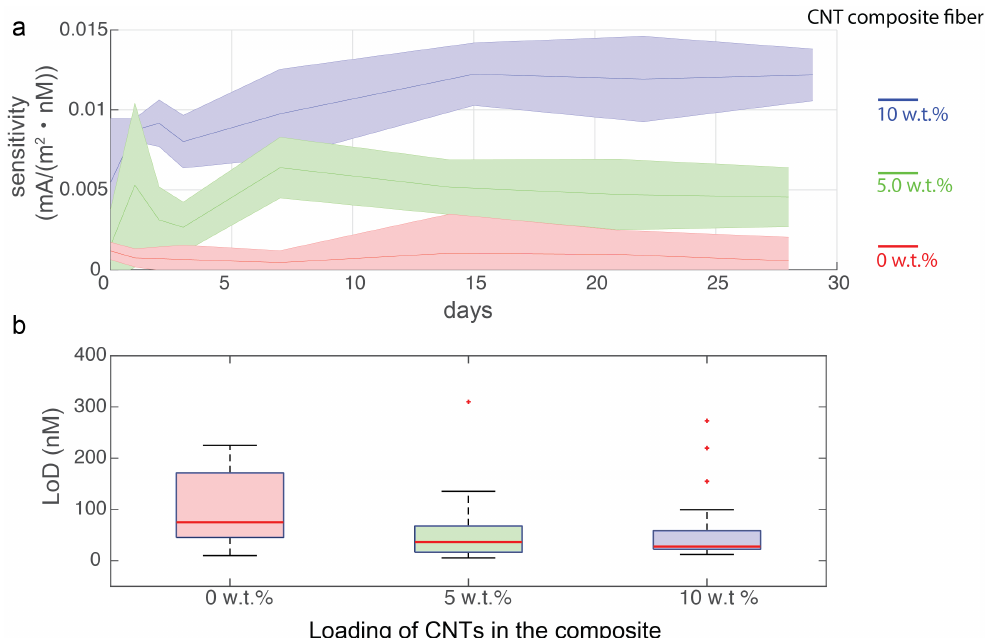
Figure 5. The long-term evaluations of the sensing performance (1 month) of the CNT nanocomposite fibers. ( a ) The sensitivity evolvement of the CNT nanocomposite fibers with different loadings. Different groups of CNT-based nanocomposite fibers are color coded. The solid line indicates the median of the sensitivity and the shaded area represents the standard deviation across samples. (N = 4 for 5, 10 wt% samples and N = 3 for 0 wt% samples) ( b ) The whisker plot of the low detection limit (LoD) calculated from amperometric data across fiber groups during the long-term evaluation. The median LoD for 0 wt%, 5 wt%, and 10 wt% are 75.0 nM, 36.4 nM, and 27.6 nM, respectively.